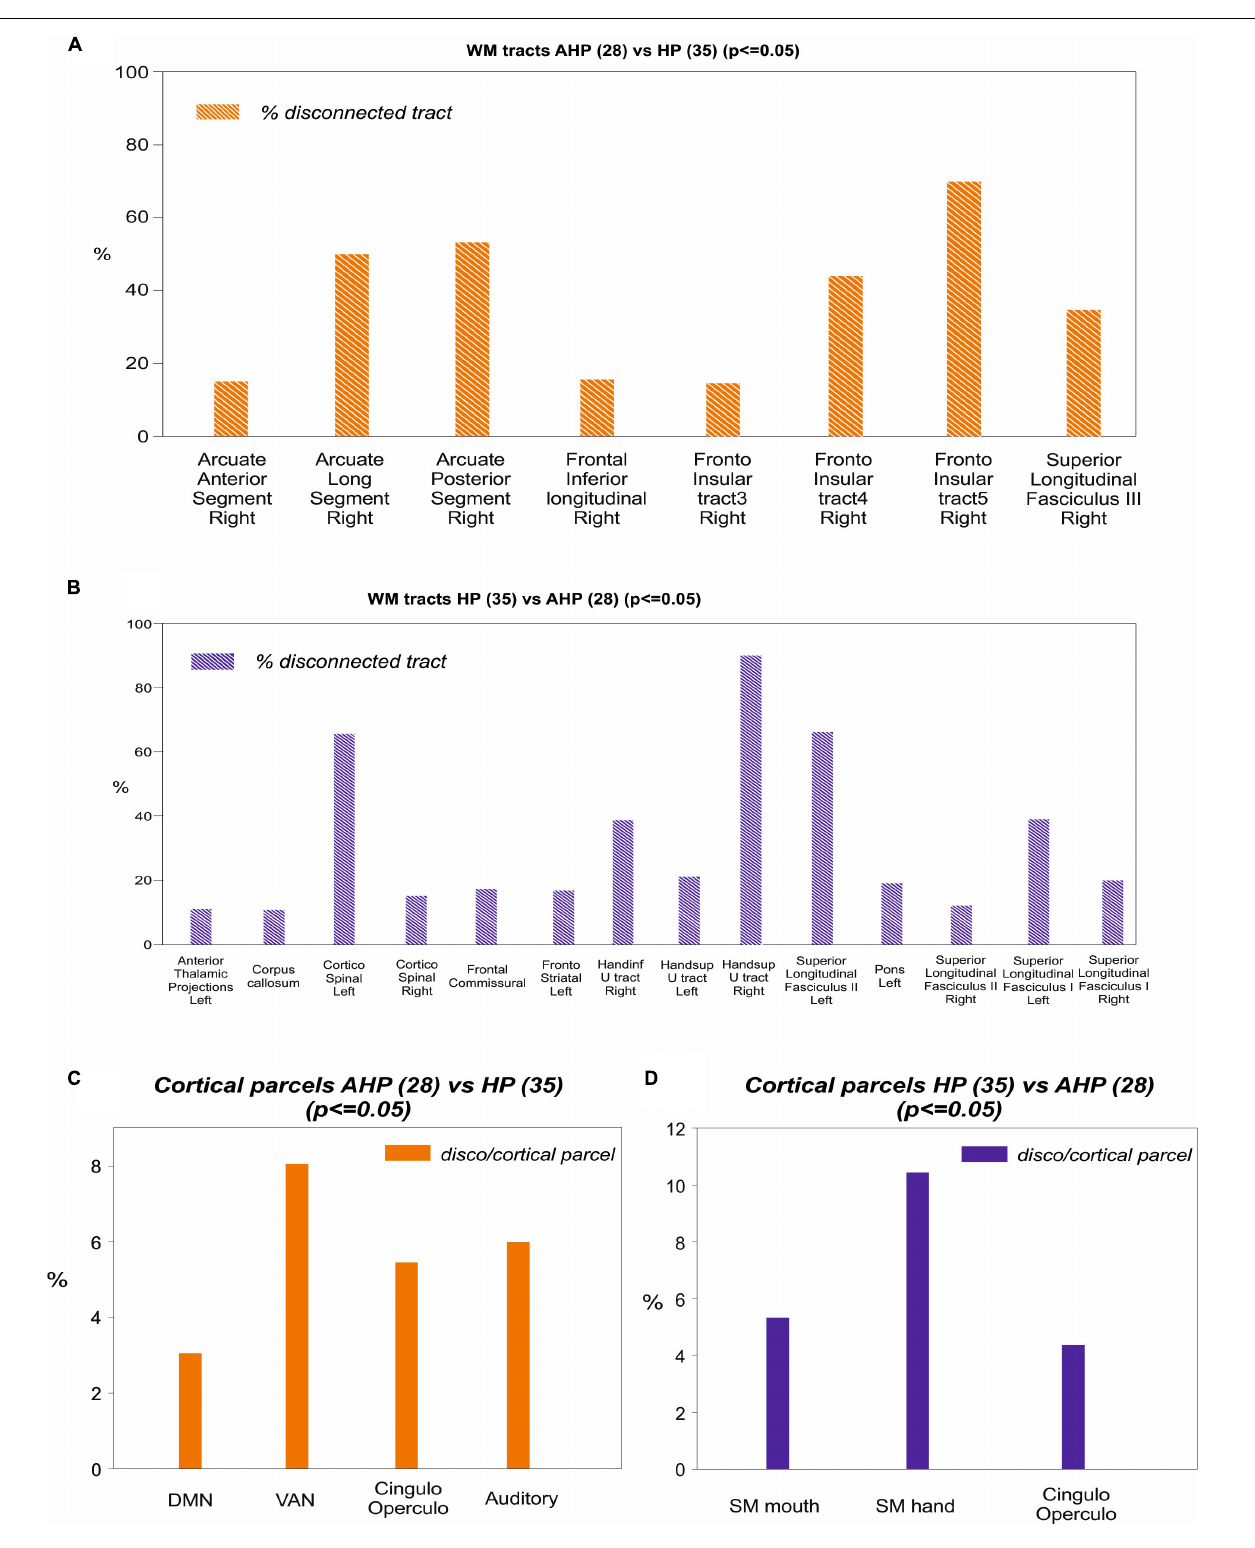
FIGURE 5 | Mapping of disconnection maps on white matter tracts and cortical networks. (A) AHP vs HP: individual white matter tracts’ overlap with disconnectome map ( > 10% disconnected tract, orange bar). (B) Same for HP vs AHP (in blue). (C) AHP vs HP: % overlap > 2% with cortical parcellation networks based on the Gordon–Laumann atlas (disco/cortical parcel, orange bar). (D) Same for HP vs AHP (in blue).